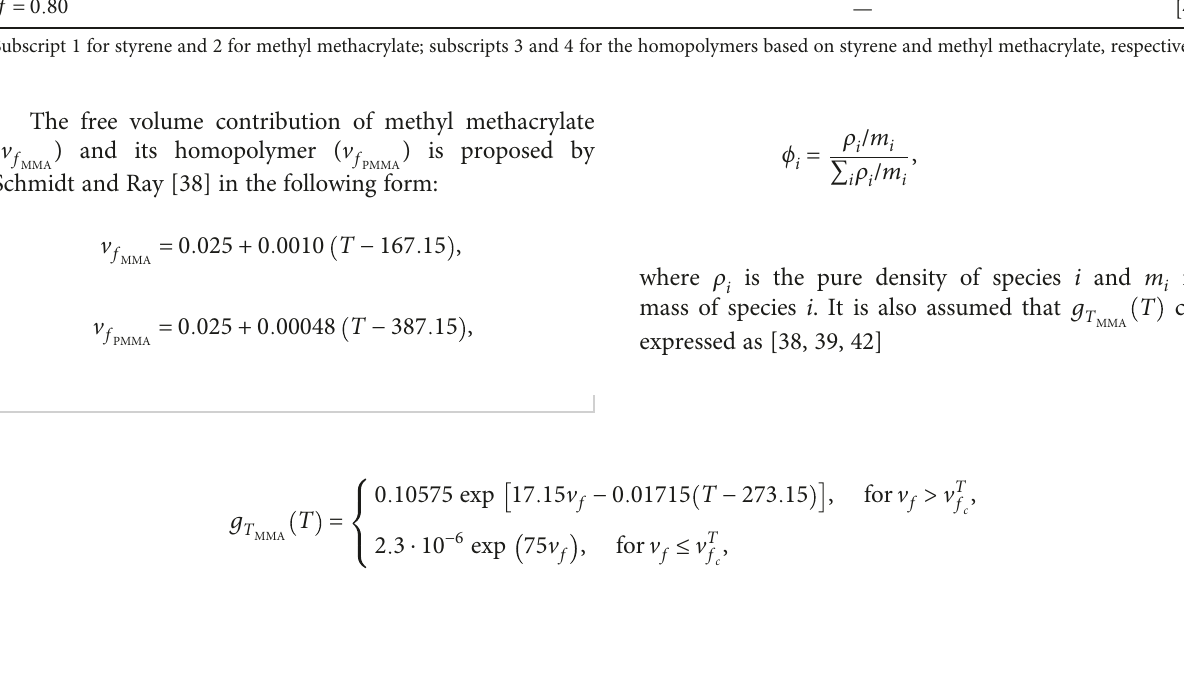
Table 1: Model parameters used for simulation of styrene/methyl methacrylate system. Parameter Unit